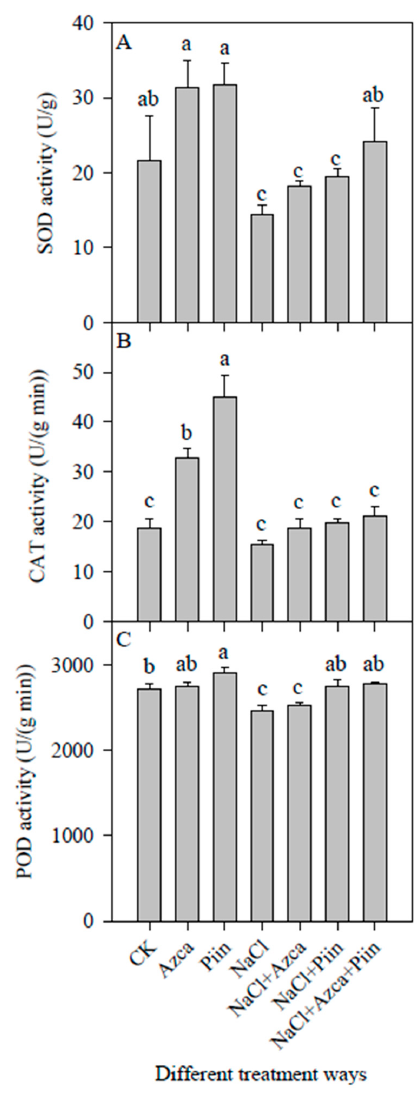
Figure 6. Changes in antioxidant enzymes in leaves of tomato plants under different treatments. ( A ): SOD activity; ( B ): CAT activity; and ( C ): POD activity. Results were shown as mean ± SE ( n =